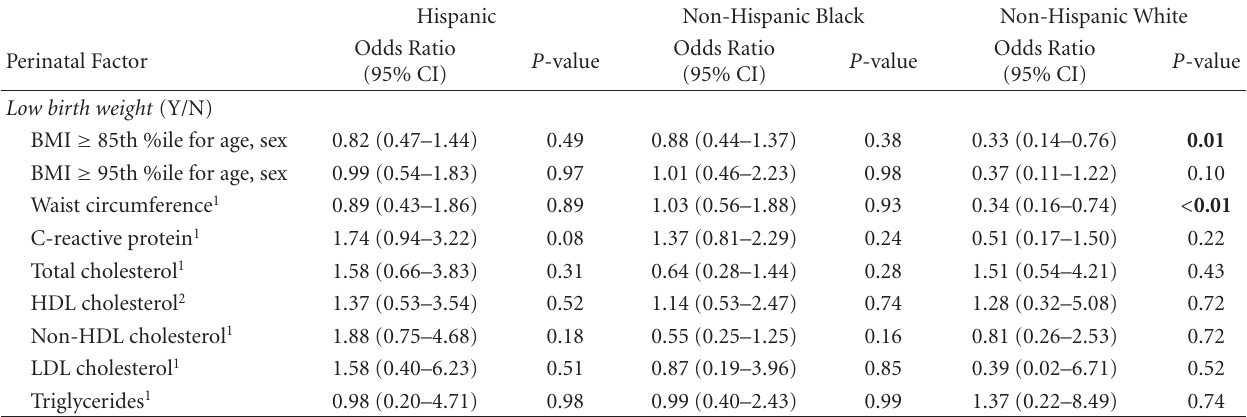
Table 6: Elevated cardiovascular disease risk factors among US 3-to-6-year-olds if low birth weight, by ethnic group, National Health and Nutrition Examination Survey,